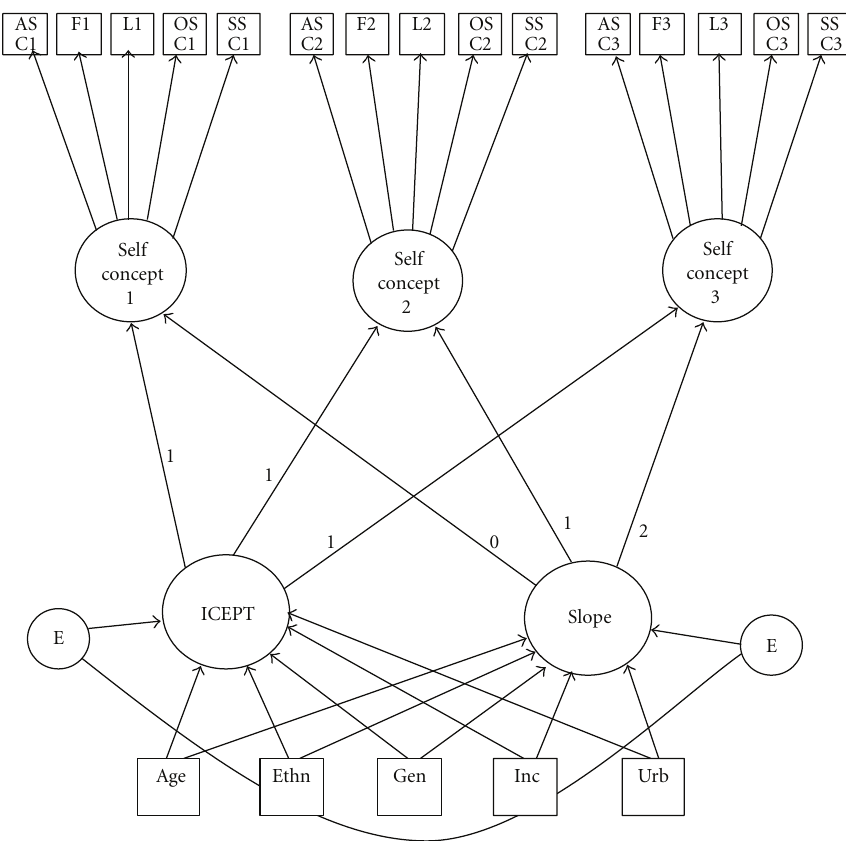
Figure 1: Full Hypothesized Latent Growth Model. ASC is academic self-concept, F is friendship, L is loneliness, OSC is overall self-concept, and SSC is social self-concept. Numbers following each variable represent wave, with 1 for Wave 1, 2 for Wave 2, and 3 for Wave 3. ICEPT is for the intercept, E is for error, Ethn is ethnicity, Gen is gender, Inc is income, and Urb is urbanicity.